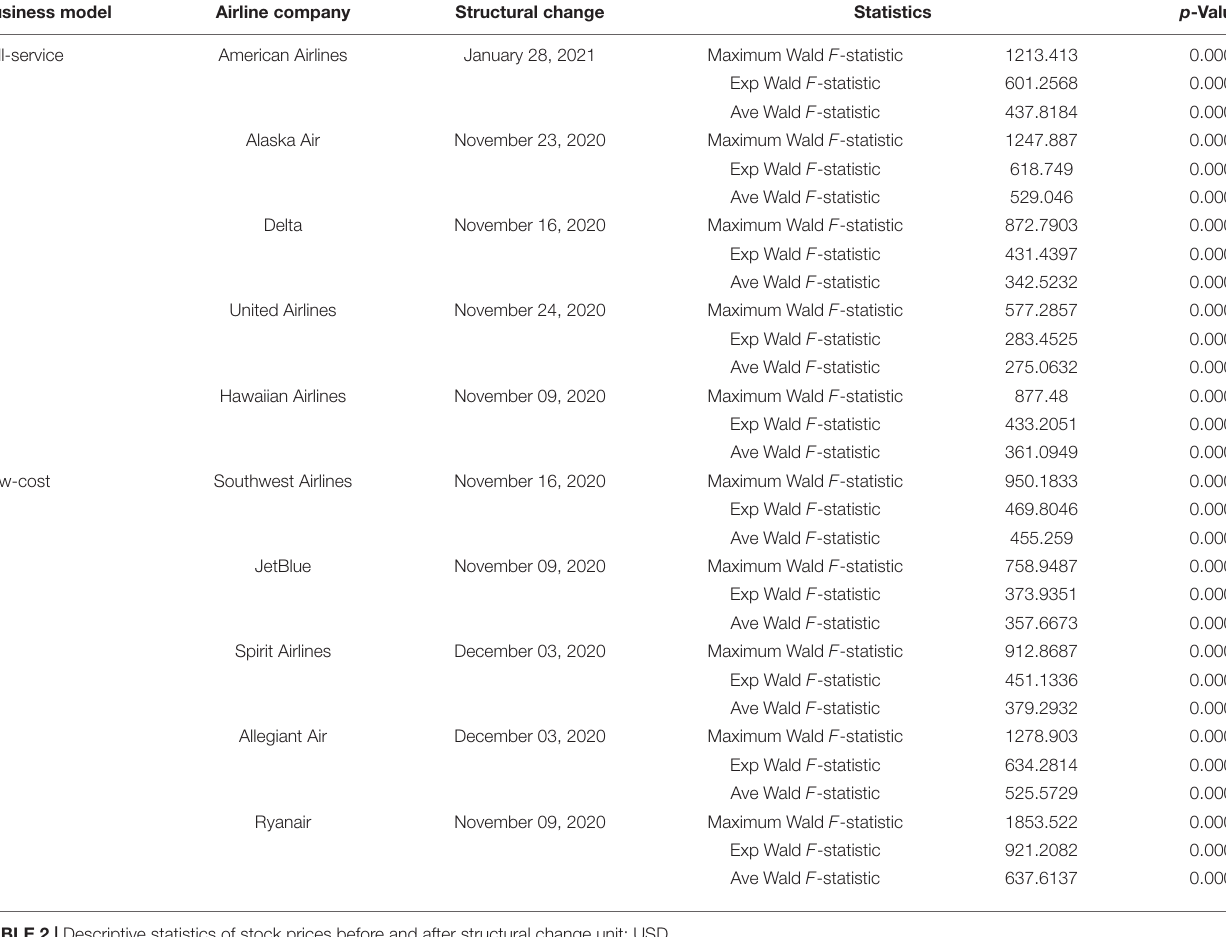
TABLE 1 | Quandt–Andrews test results.